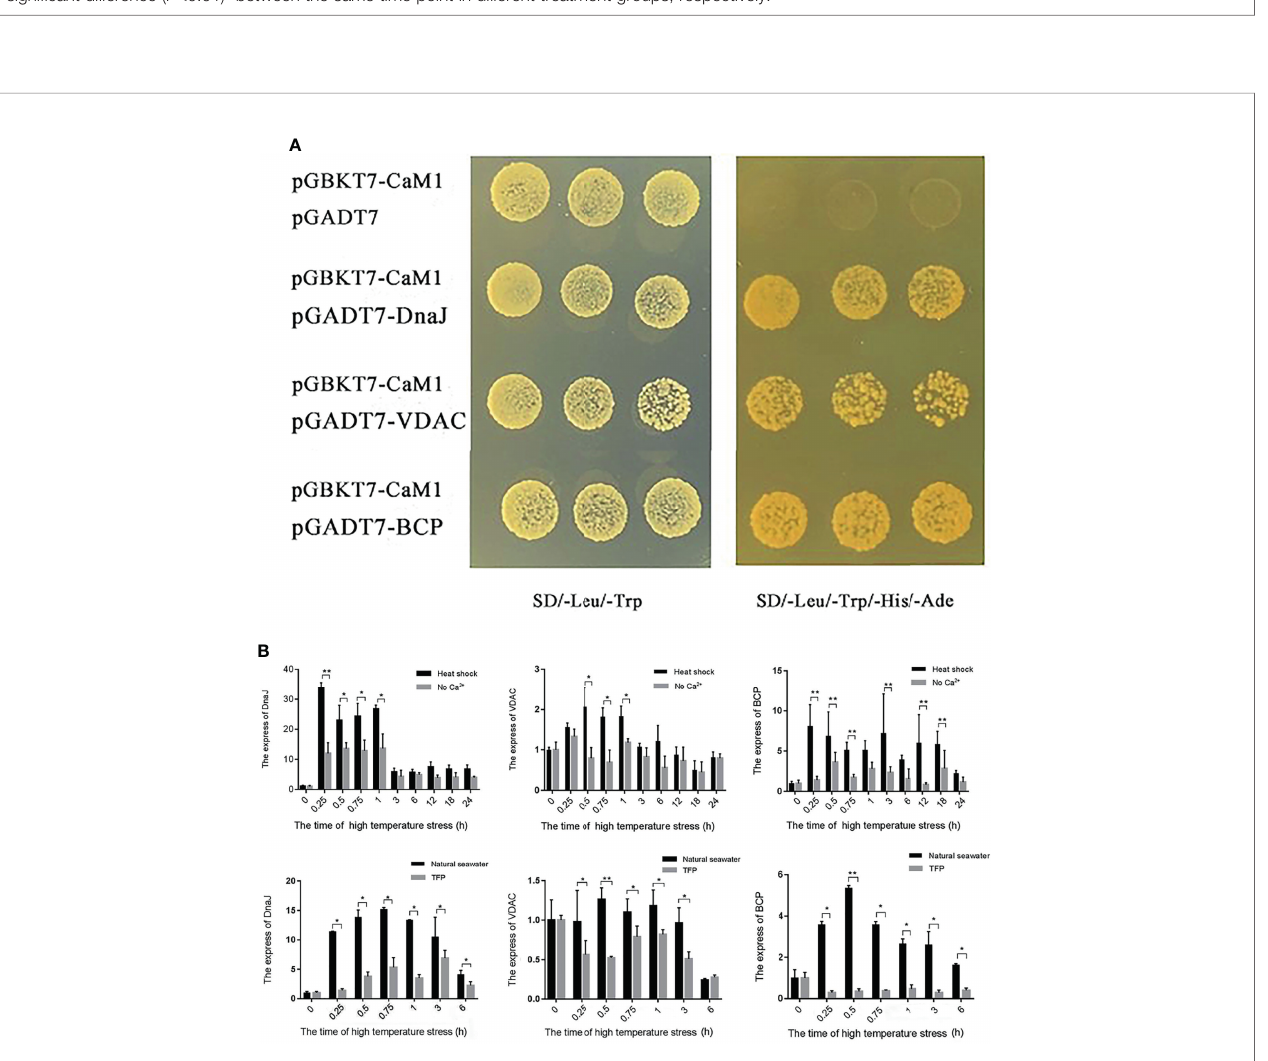
FIGURE 4 | Screening for NhCaM1 interaction partners by yeast two-hybrid analysis, and gene transcript levels in thalli of N. haitanensis under different treatments. (A) Screening for proteins that interact with NhCaM1 in N. haitanensis under heat stress by yeast two-hybrid analysis; (B) Transcript levels of genes encoding proteins that interact with NhCaM1 in N. haitanensis thalli under different treatments. TFP: tri fl uoperazine, a CaM inhibitor. * and ** represent signi fi cant difference (P< 0.05) and extremely signi fi cant difference (P<0.01) between the same time point in different treatment groups, respectively.